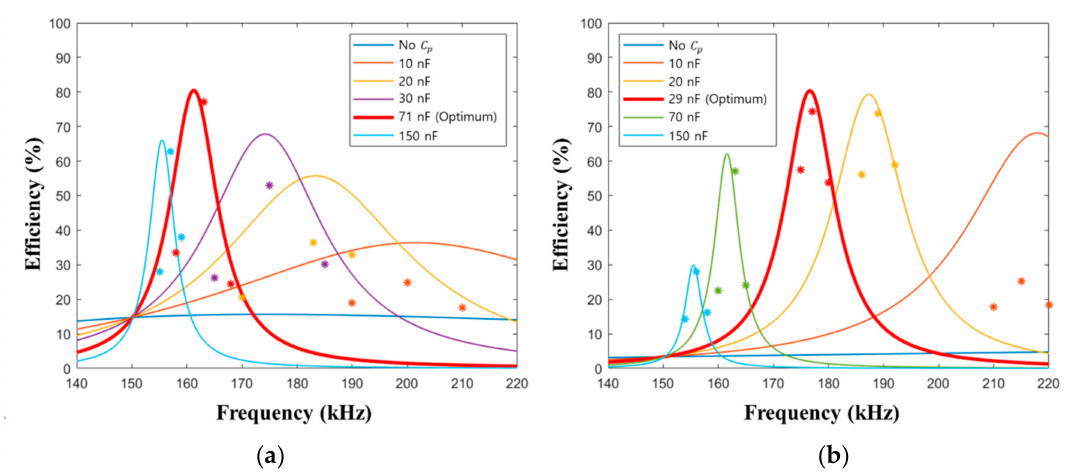
Figure 5. Power transfer efficiency as a function of frequency with different C p condition. ( a ) R L = 100 Ω , ( b ) R L = 500 Ω